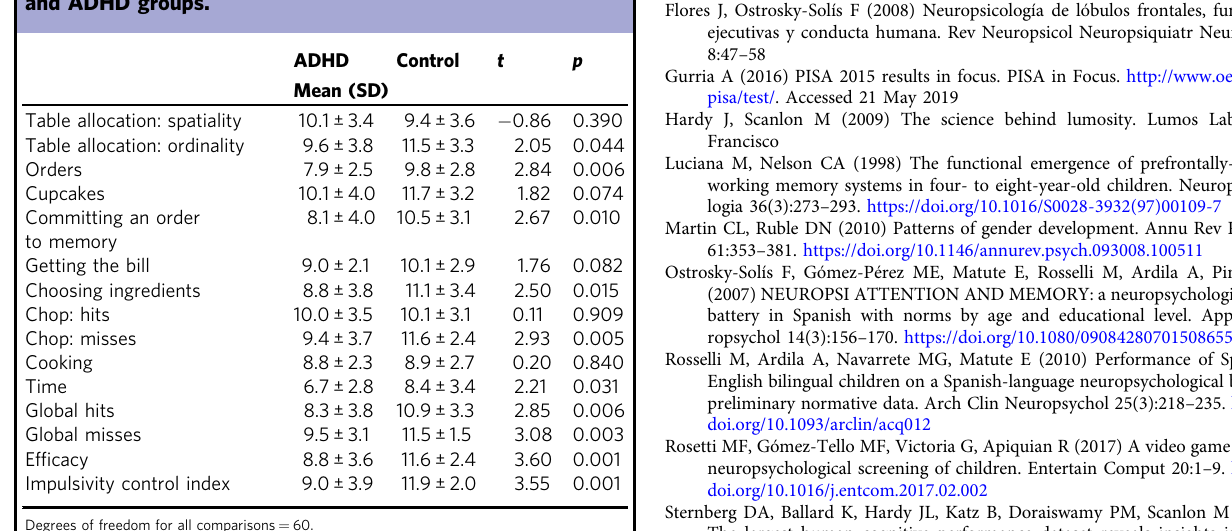
Table 4 Comparison of Chefmania scores between control and ADHD groups.